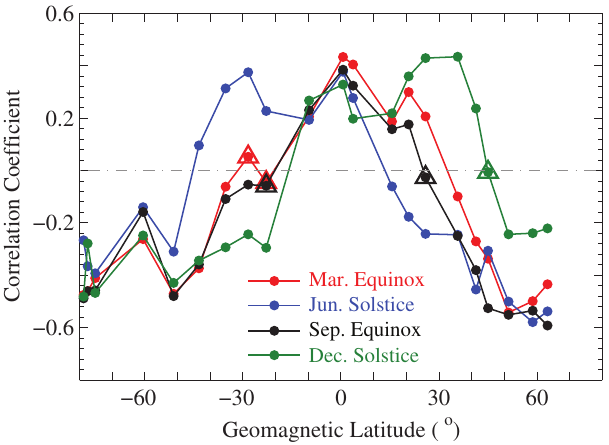
Fig. 7. Latitude variations of the correlation coef fi cient between D f o F 2 and < ap > 24 h ; the red, blue, black, and green lines correspond to the seasonal conditions of March equinox, June Solstice, September equinox, and December solstice, respectively. The dots surrounded by triangles indicate low statistical signi fi cance ( P > 0.01) of the correlation coef fi